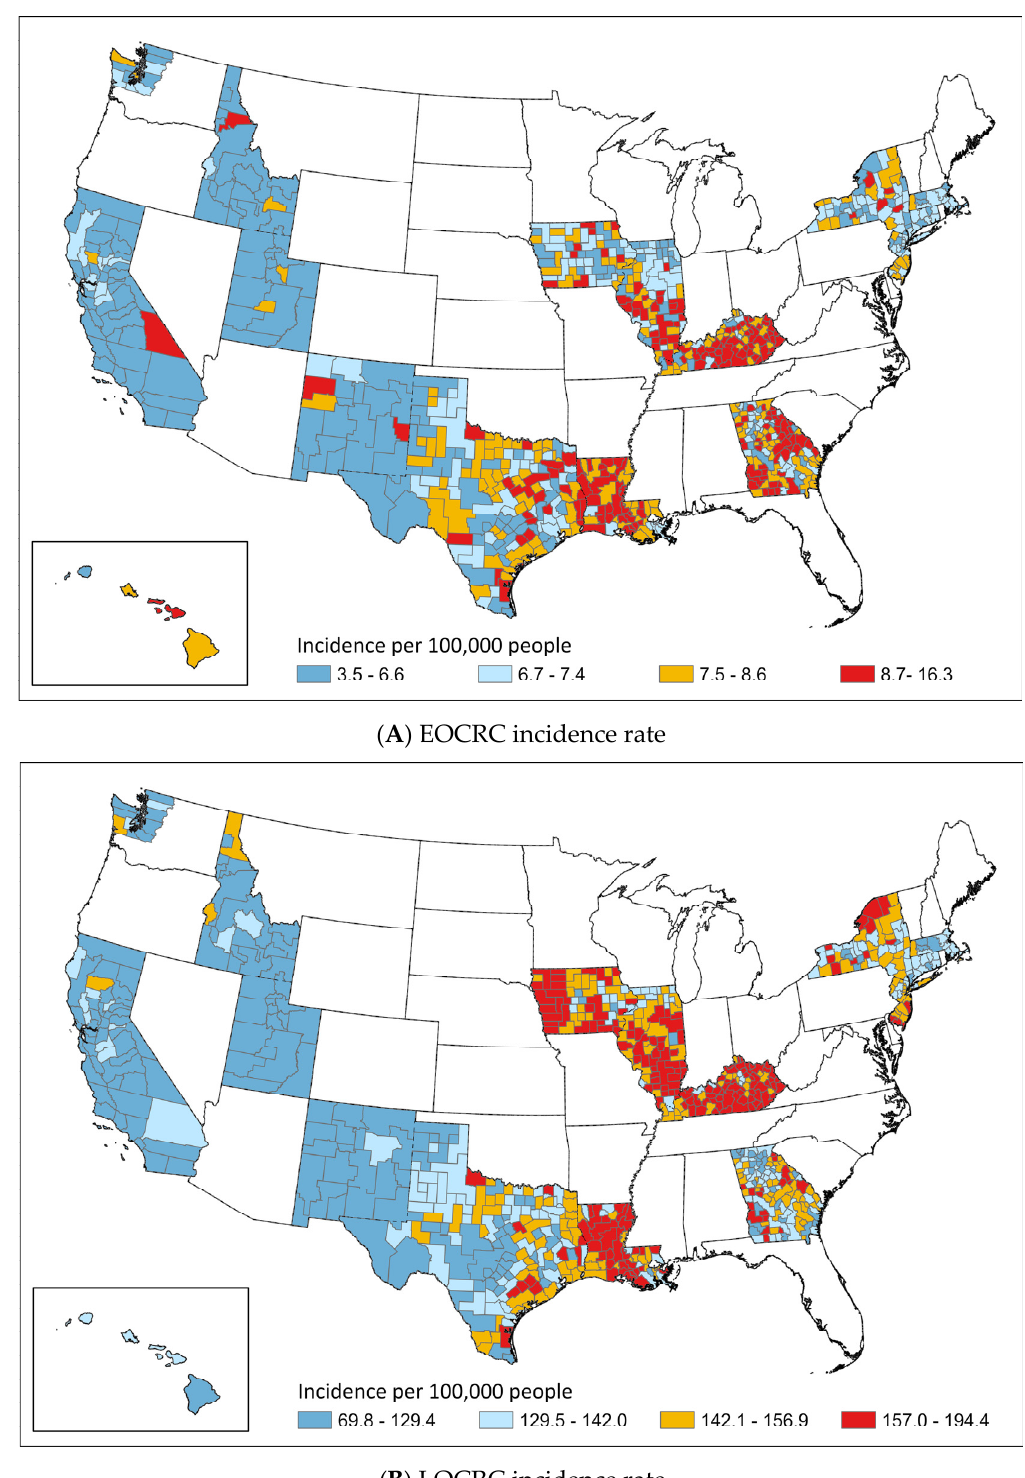
Figure 1. Geographic distribution of ( A ) EOCRC incidence rate, and ( B ) LOCRC incidence rate. Notes: Incidence rates are age-adjusted and classified by quartile. Data for states in white are not available in SEER.